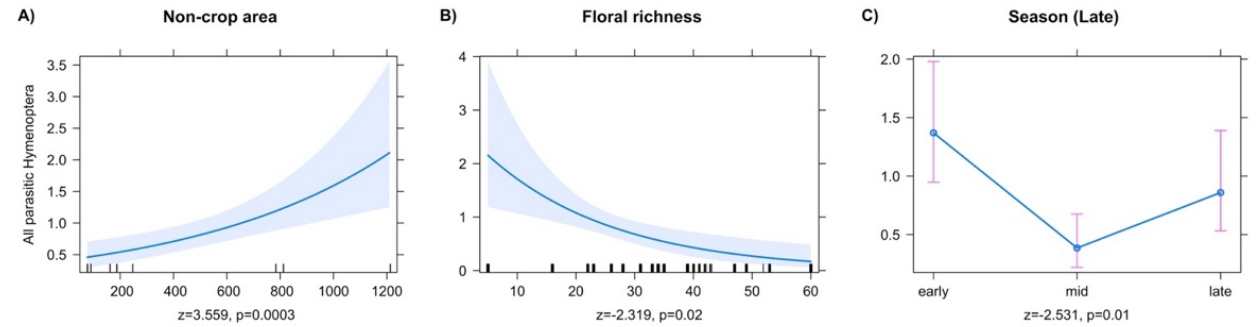
Models for the abundance of all collected parasitic Hymenoptera showed significant effects of season and local APM factors. The abundance of all PH collected increased with larger noncrop areas on the farm (Figure 1A). All PH abundance decreased with increased floral richness (Figure 1B). Despite an increase in collected PH in 2019 (2018, n = 872 and 2019, n = 1007), models that included season as an explanatory variable (early, mid, and late) and year (2018 or 2019) showed a significant overall decrease in PH abundance in late season (Figure 1C, z = − 2.531, p = 0.011).